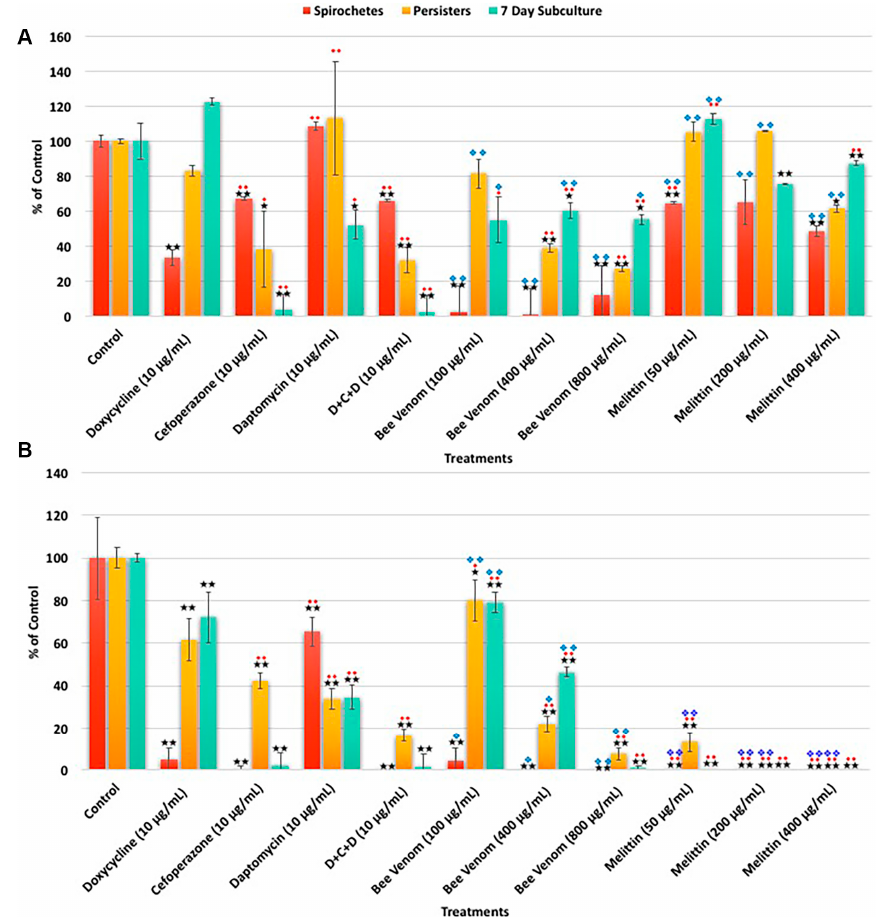
Figure 1. The effects of various antimicrobial agents on B. burgdorferi as determined by SYBR Green I/PI assay Panel ( A ) or direct counting assay Panel ( B ). Doxycycline, Cefoperazone, Daptomycin and their combination (D + C + D) as well as different concentrations of bee venom and melittin were tested on B. burgdorferi logarithmic phase (spirochetes) culture and stationary phase (persisters) cultures as well as in 7-day recovery subculture as described previously [6–8]. Significance against sterile PBS buffer (control vehicle) with the p value of <0.05 and <0.01 are indicated in * and ** respectively. Significance against Doxycycline with the p value of <0.05 and <0.01 are indicated in ♦ and ♦♦ respectively. Significance against the three-antibiotic combination (D + C + D) with the p value of <0.05 and <0.01 are indicated in ❖ and ❖❖ respectively. n = 9.